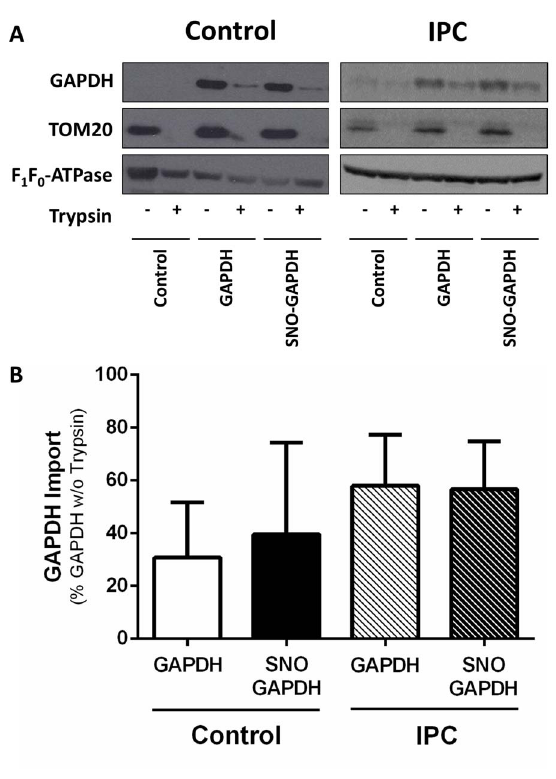
Figure 3. GAPDH and SNO-GAPDH are imported into the matrix of heart mitochondria. Mitochondrial GAPDH protein levels were assessed after the addition of purified GAPDH or SNO-GAPDH to isolated mitochondria from control and IPC hearts. ( A ) Representative western blots for GAPDH (upper), TOM20 (center), and the a subunit of F 1 F 0 -ATPase (lower) in control heart and IPC heart mitochondria. Control: non-treated mitochondrial control; GAPDH: purified GAPDH treated mitochondria; SNO-GAPDH: SNO-GAPDH treated mitochondria. ( B ) GAPDH import into control and IPC heart mitochondria as assessed via the percentage of GAPDH following trypsin digestion compared to GAPDH levels prior to the addition of trypsin. GAPDH levels were assessed via densitometry (n=3).